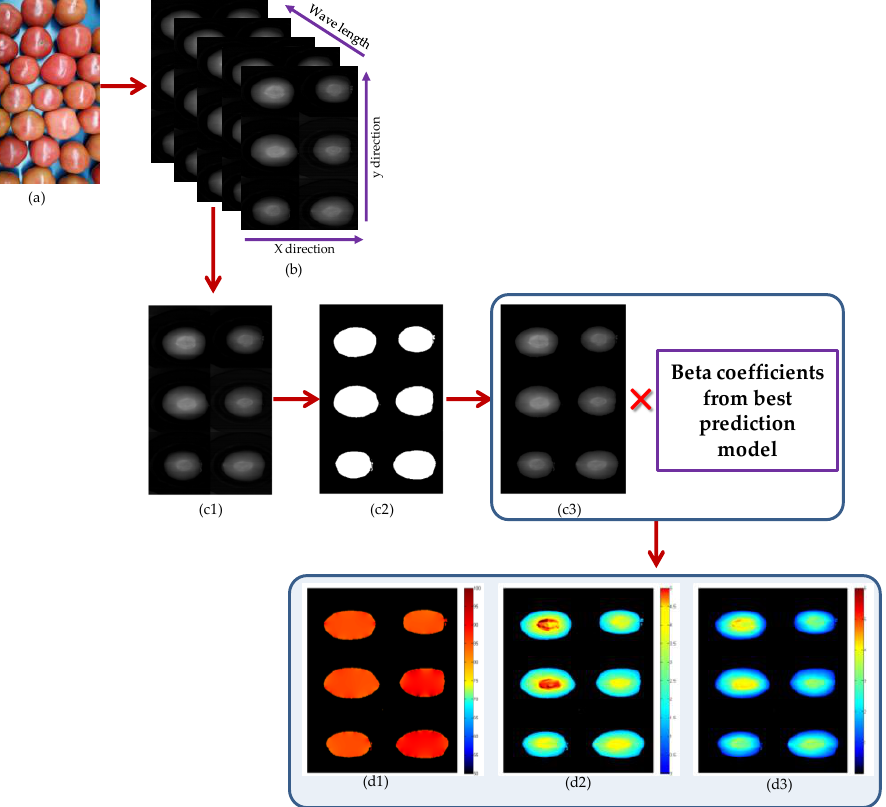
Figure 6. ( a ) Tomato samples; ( b ) 3-D hypercube of tomato image; ( c1 ) Corrected grayscale image at 1082 nm; ( c2 ) Binary image at 0.1 threshold; ( c3 ) Resultant grayscale image after masking with the previous image; ( d1 – d3 ) Chemical image of MC, pH and SSC